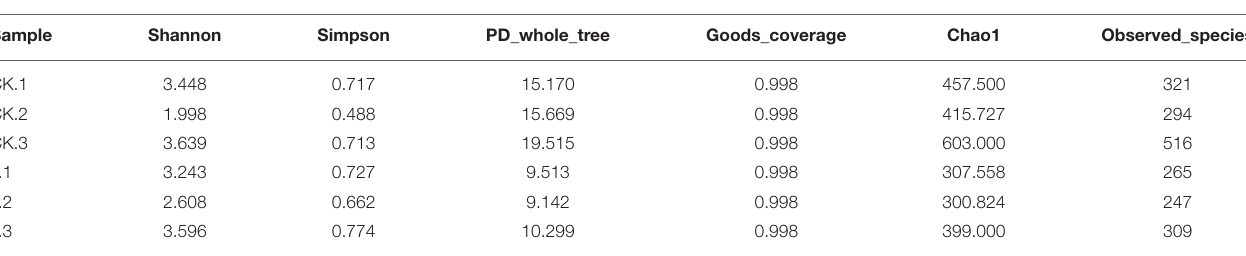
TABLE 2 | Samples alpha diversity analysis